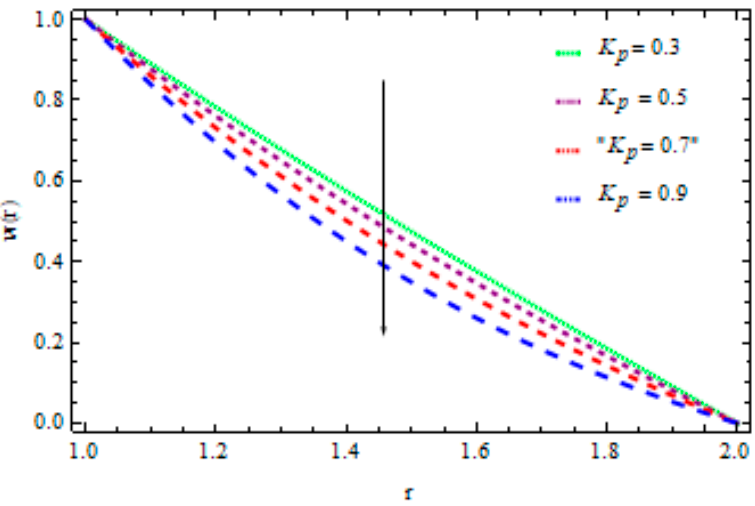
Figure 3. The influence of K p on velocity distribution in case of Reynolds’ model when Q = 0.2, ε = 0.6, N = 0.1, m = 0.4, β 0 = 0.1, B r = 0.2, = 0